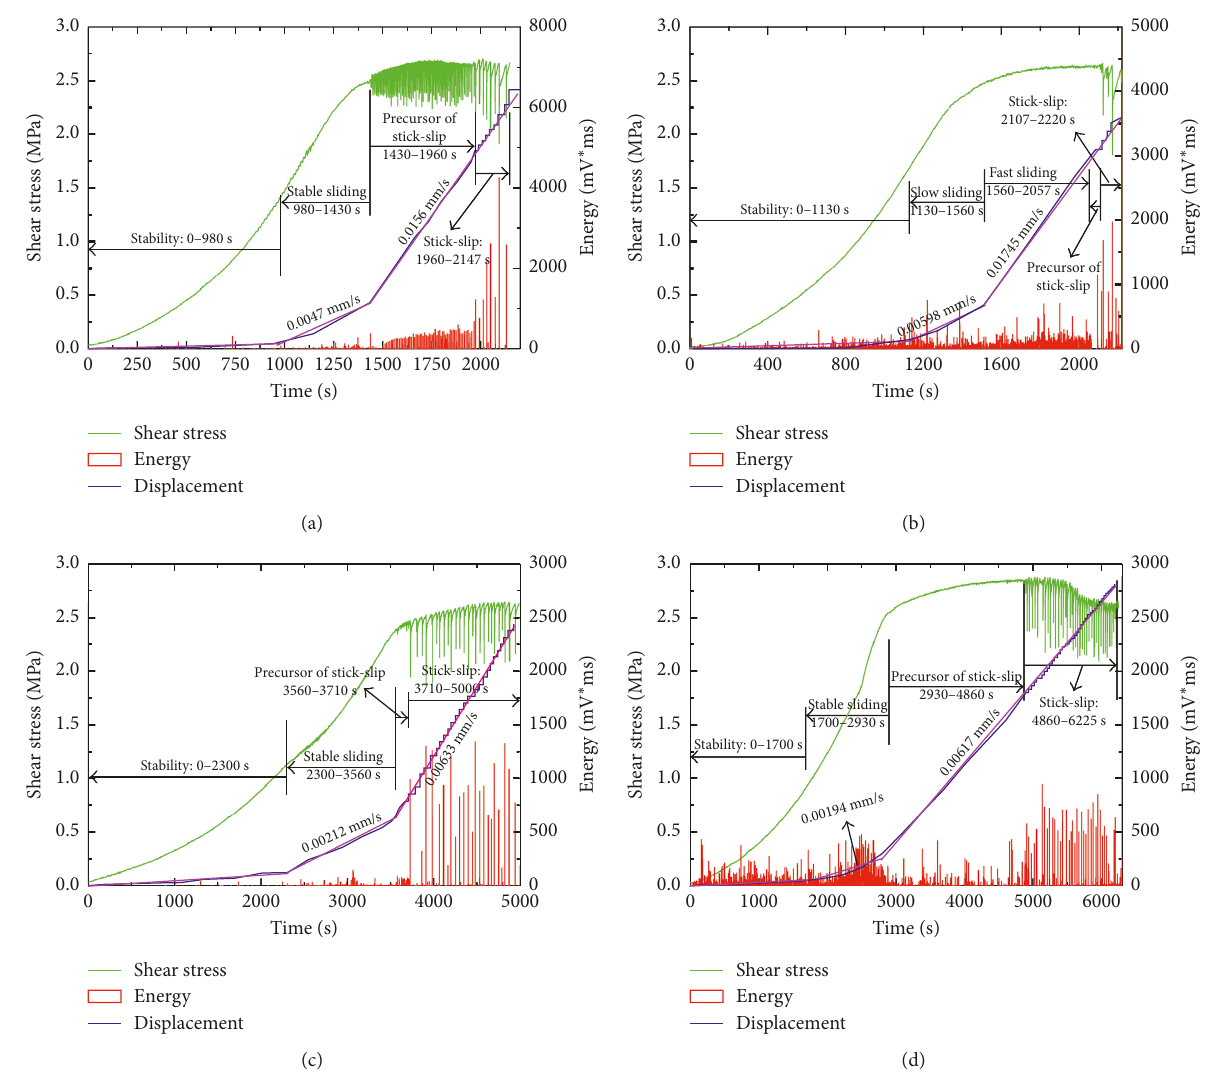
Figure 8: Correlation between shear stress, AE energy, and displacement during slipping. Note: for Sample 1, the displacement value (unit: mm) is 6 times of its shear stress value. Similarly, the multiples of Samples 2–4 displacement are 5, 9, and 7, respectively. (a) Sample 1. (b) Sample 4. (c) Sample 2. (d) Sample